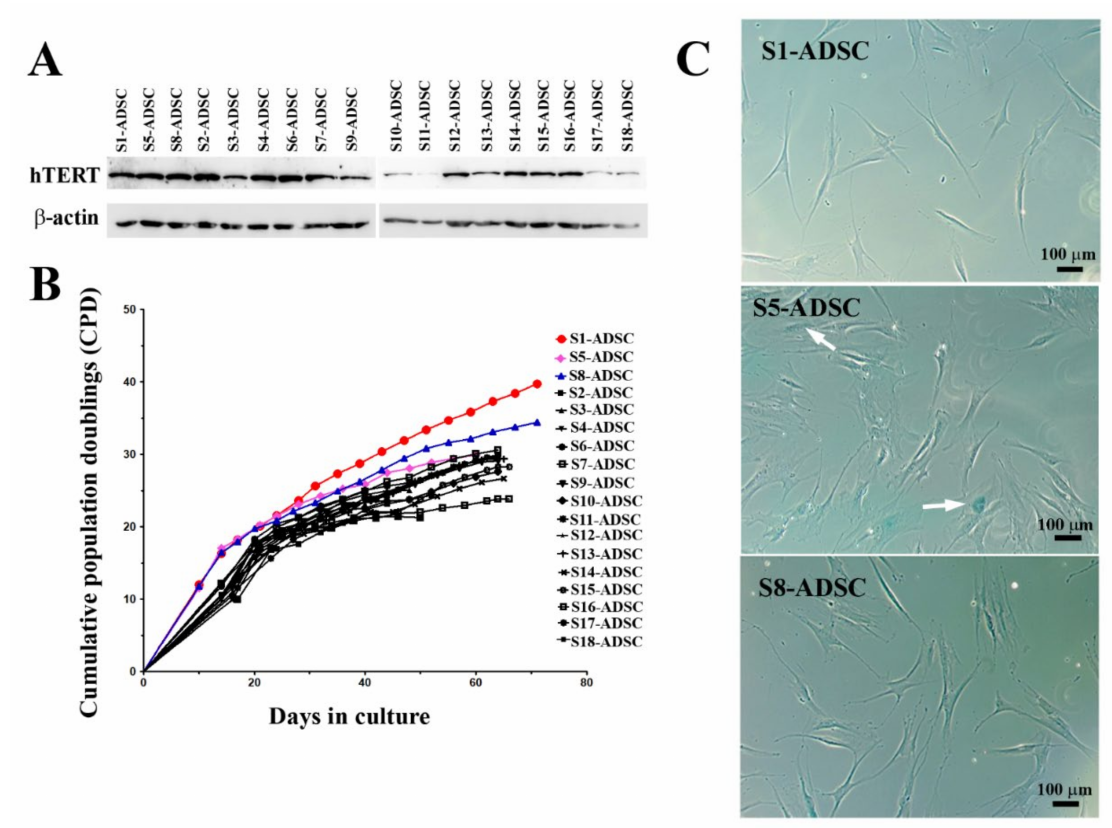
Figure 3. Analysis of hTERT expression, proliferation rates and senescence marker β -galactosidase of hTERT-transduced ADSC-derived sub-populations. ( A ) Expression of hTERT in 18 hTERT-transduced ADSC sub-populations as revealed by Western Blot technique. ( B ) Comparison of proliferation rates of hTERT ADSC-derived sub-populations. Note that two subpopulations (S1 and S8-ADSC) had high proliferation activity, while the rest of the tested cells stopped proliferating after 29–30 population doublings. ( C ) Senescence-associated β -galactosidase assay performed at passage #10 after transduc- tion, showing the lack of enzyme activity in high-proliferative sub-populations S1 and S8-ADSC and a noticeable activity in sub-population S5-ADSC, which stopped proliferating after 30 population doublings ( β -galactosidase positive cells are indicated with white